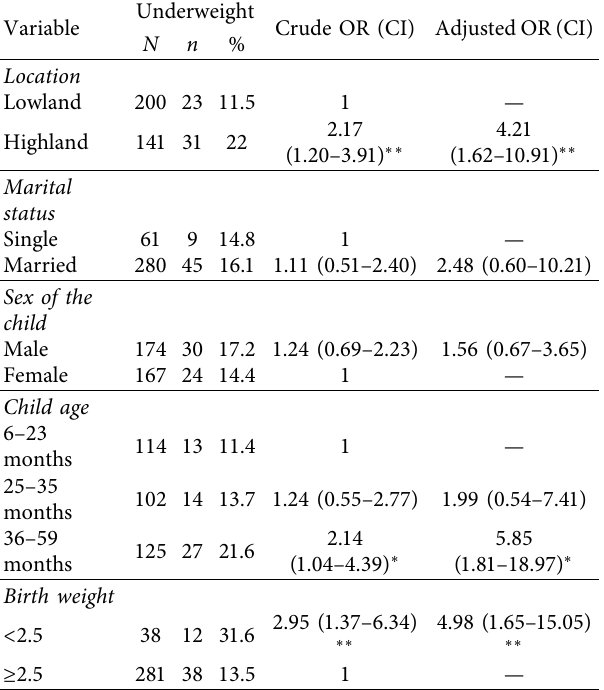
Table 4: Determinants of underweight in children: crude and adjusted